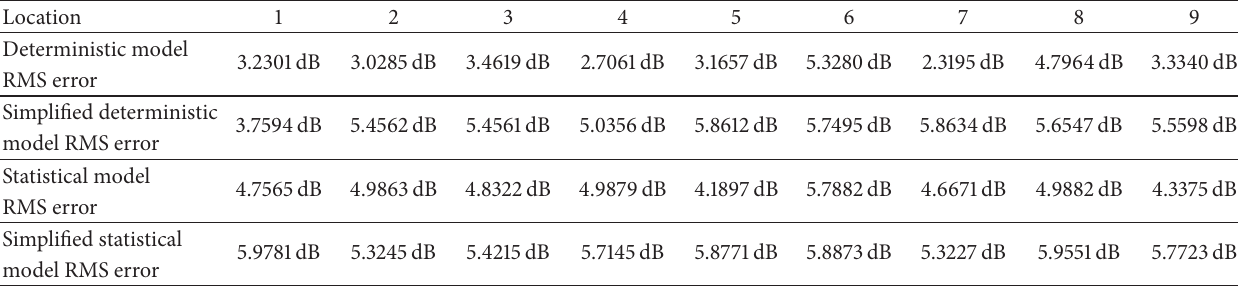
Table 3: Received signal power RMS error in downlink scenario.